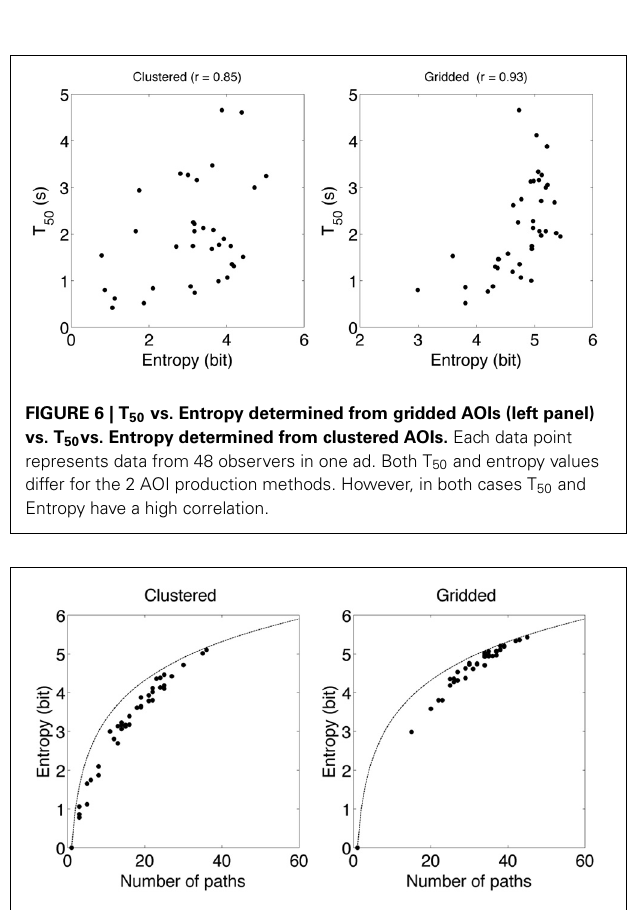
FIGURE 7 | Entropy as function of the number of scan paths. A single dot represents data from an individual advertisement. The line denotes the maximum entropy given the number of paths. The previous is calculated from a flat distribution of scan paths. In the gridded condition for high number of paths the measured entropy resembles the maximum entropy for that specific number of paths. In the clustered condition for both high and low number of paths the measured entropy resembles the maximum entropy for that specific number of